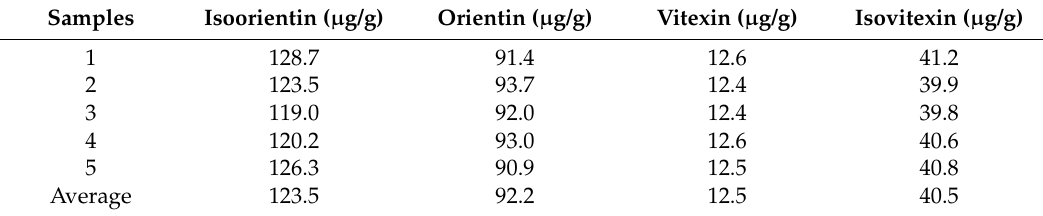
Table 2. The content of the individual flavonoids in P. pubescens leaves samples obtained by